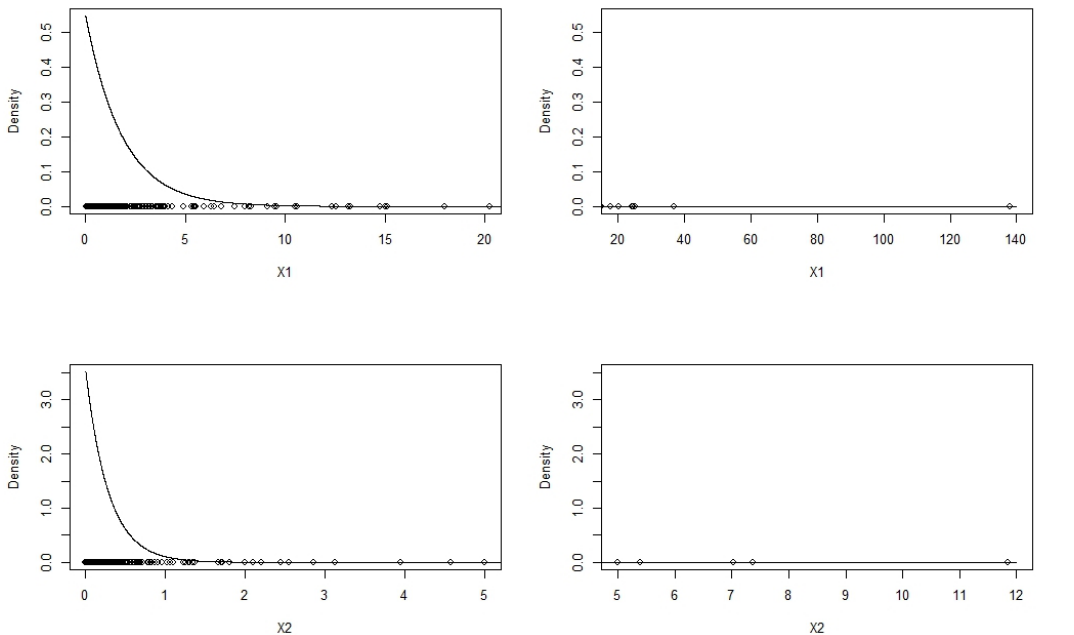
Figure 5. Exponential pdf fitted by MLE and sample data shown as points on the horizontal axis for both